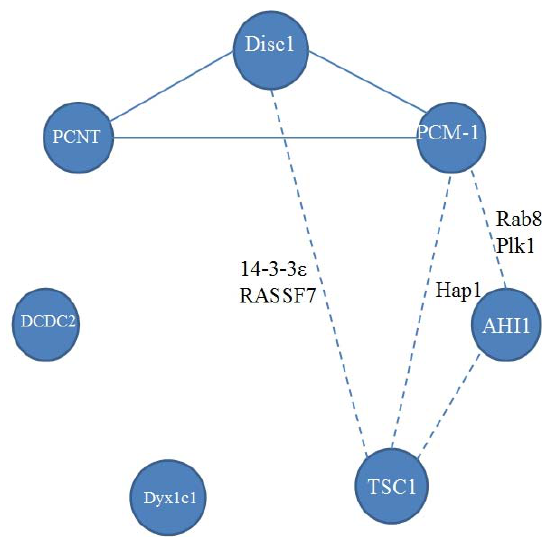
Figure 2. A scheme of known relations between proteins under review. Continuous line between proteins means direct interactions. Dashed line means that a pair of proteins has common binding partners, their names are given near the dashed line.